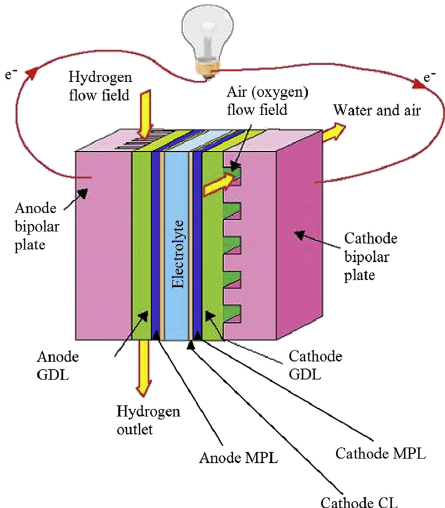
Figure 7. Sketch of a generic PEMFC, with MEA and additional components.